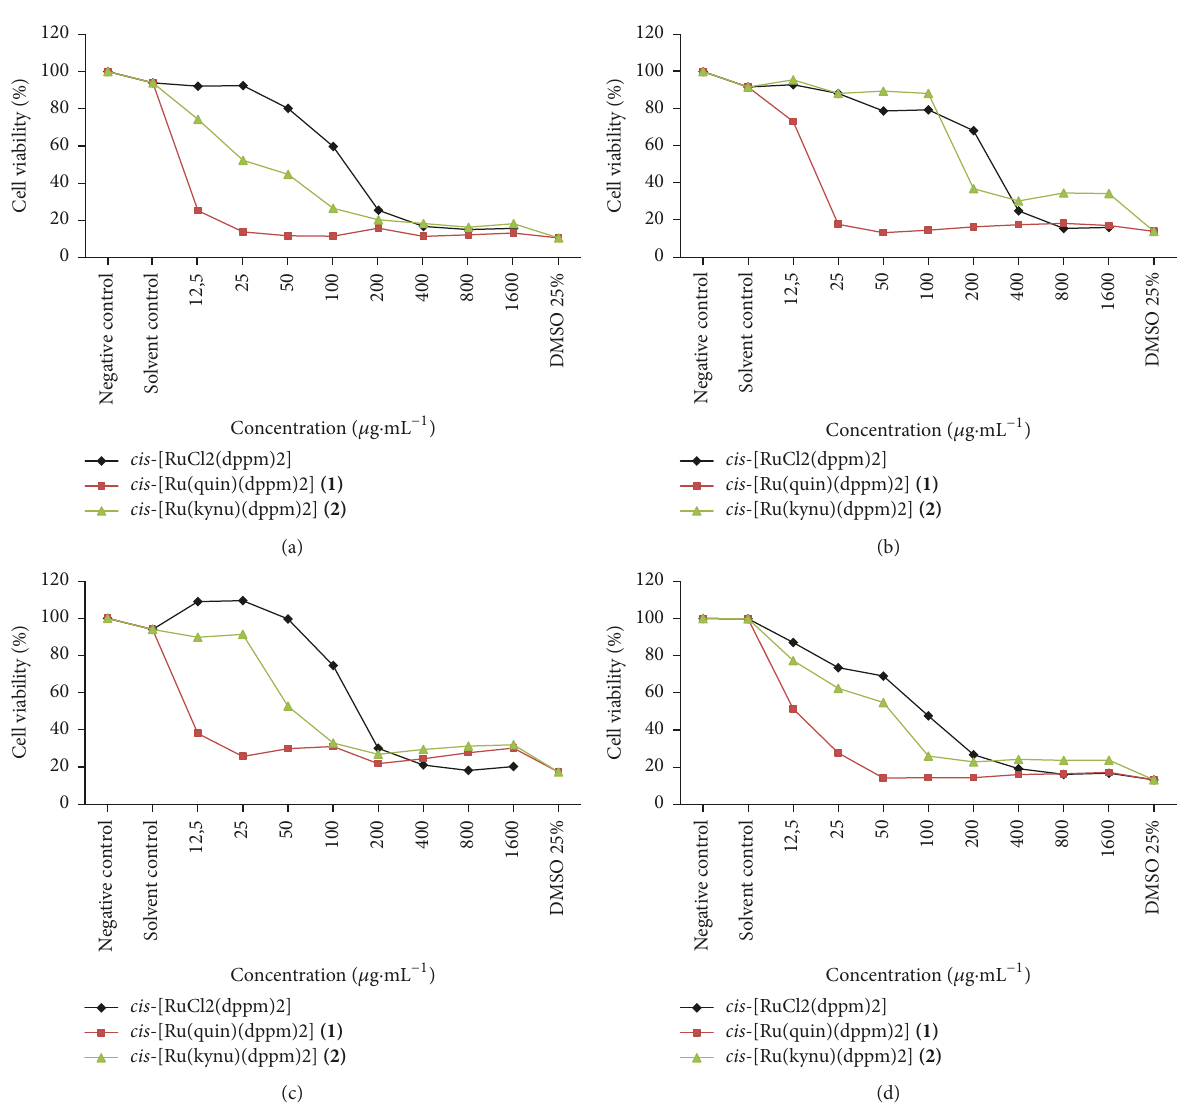
Figure 4: Invitro cytotoxicity activities ofruthenium complexes in HepG2 (a), MCF-7(b),MO59J (c), and GM07492A (d)cells after exposure for 24h. The concentration-effect curves were determined using XTT assay. Each data point is the mean ± standard error obtained from three independent